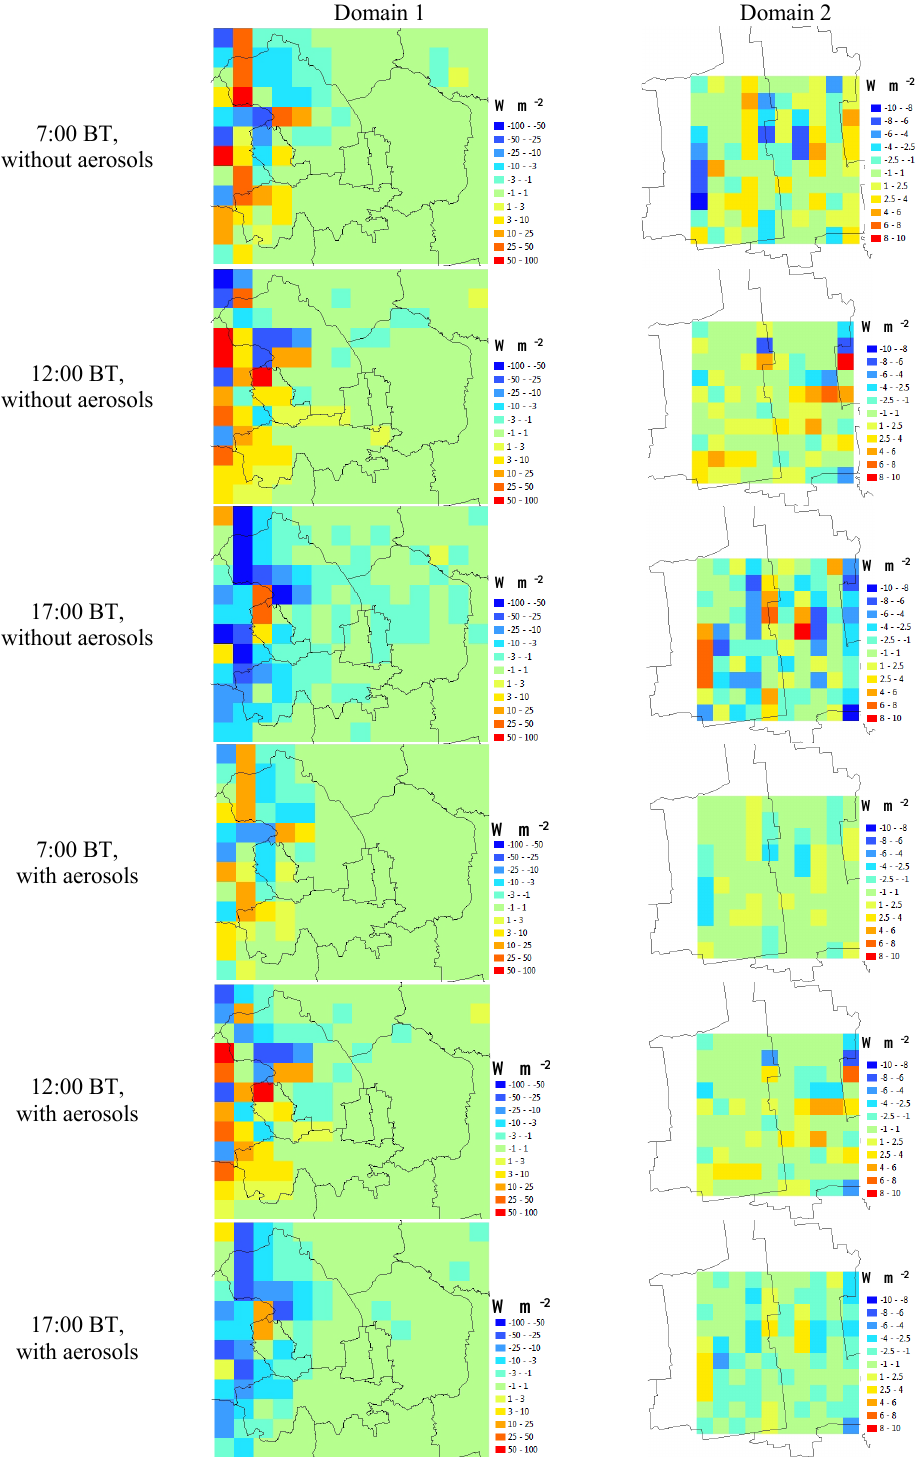
Figure 2. Surface solar flux deviations between the 3-D radiation parameterization and the plane-parallel scheme at selected times (7:00, 12:00, and 17:00Beijing Time (BT)) on 1 April in conditions with and without